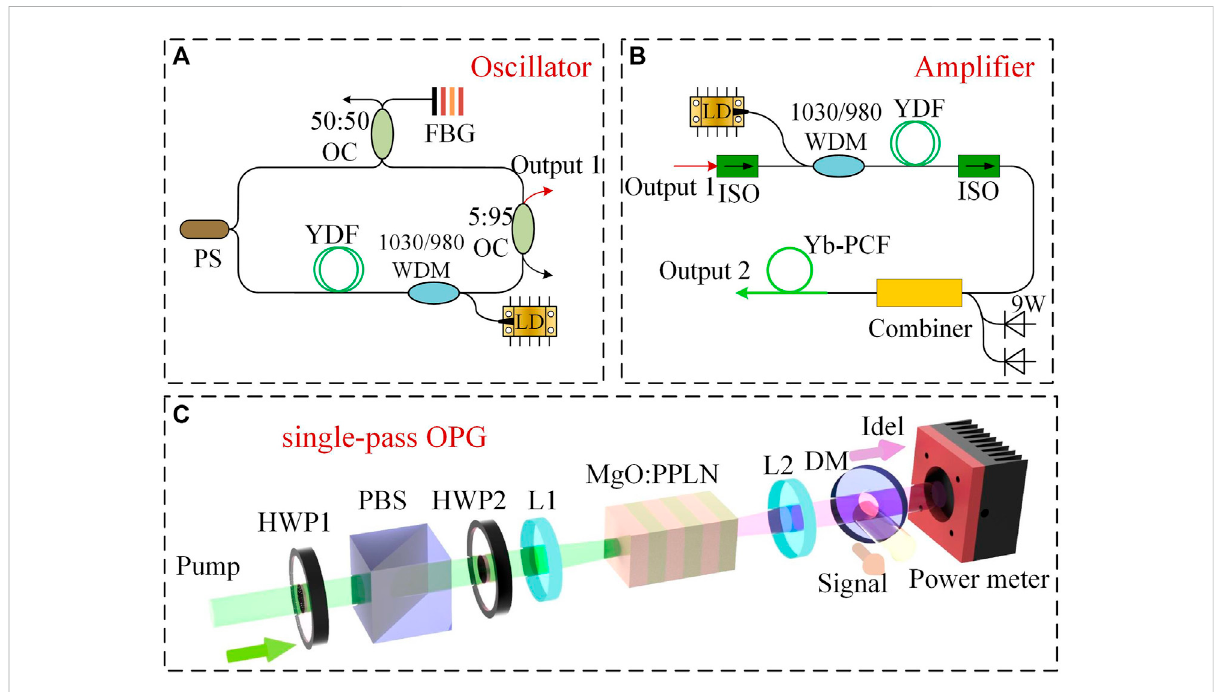
FIGURE 1 Experimental of fi ber laser pumped MgO: PPLN OPG. (A) Fiber oscillator. (B) Cascaded fi ber ampli fi er. (C) Mid-infrared generation using the OPG